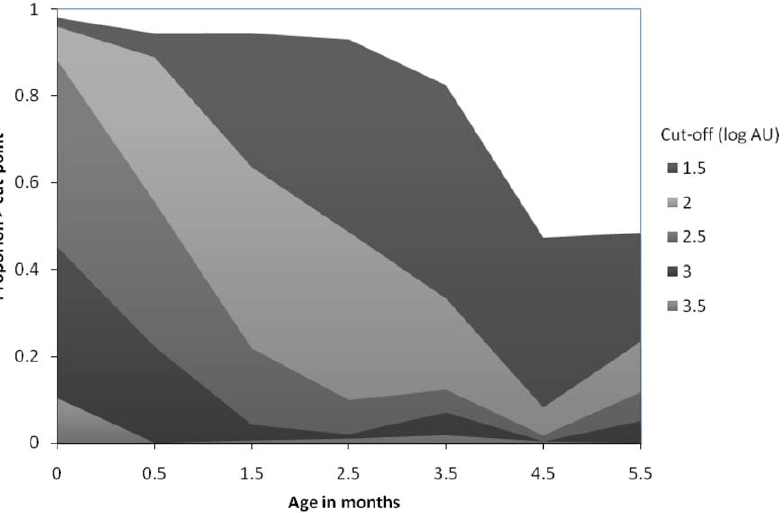
Figure 4. Age-seroprevalence profile at various cut-off levels of seropositivity. The assay cut-off value of seropositivity is 1.5.